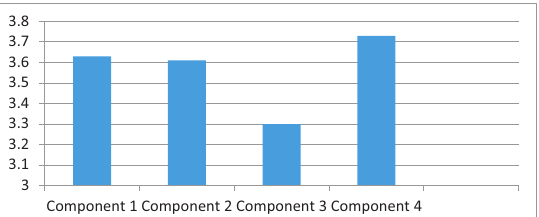
Figure 3. Average rankings of significance of the identified components